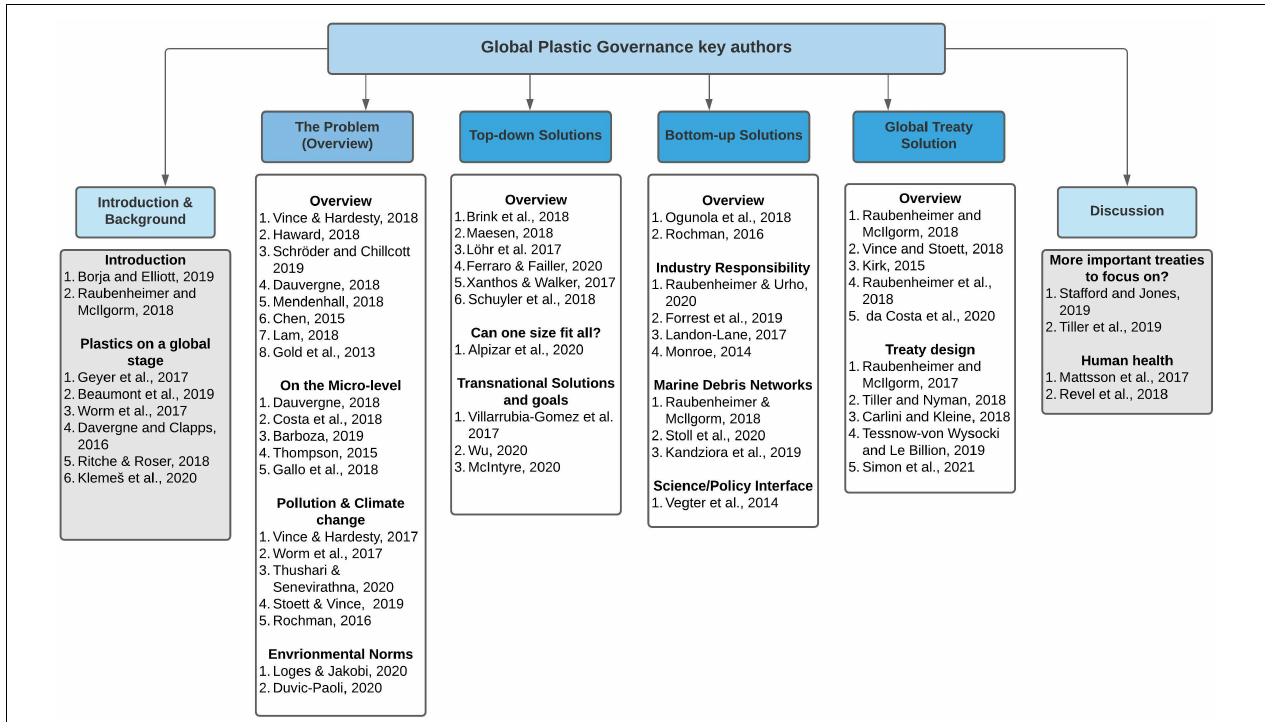
FIGURE 2 | Lucidchart demonstrating the final categories each article is placed in.